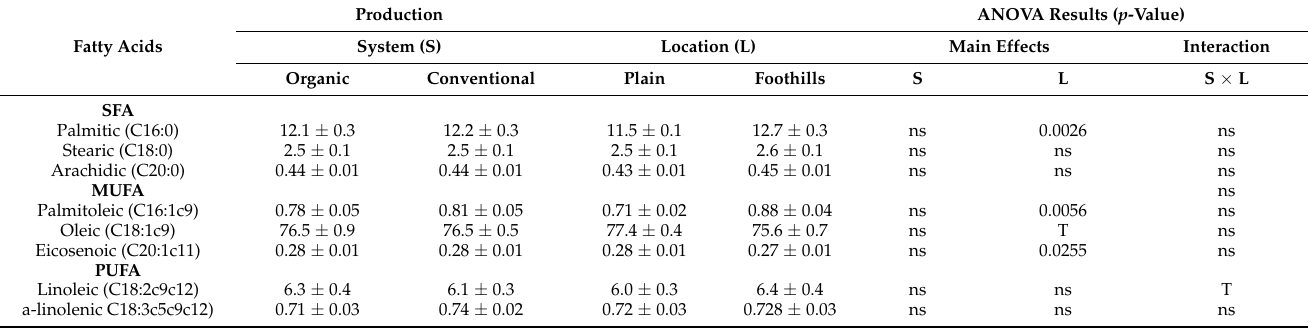
Table 6. Effect of, and interaction between, production system (organic versus conventional) and geographic location (Messara Plain or foothills) on the concentrations (% of total fatty acids) of the major fatty acids found in olive oil in harvest year 2008. Values shown are main effect means ±